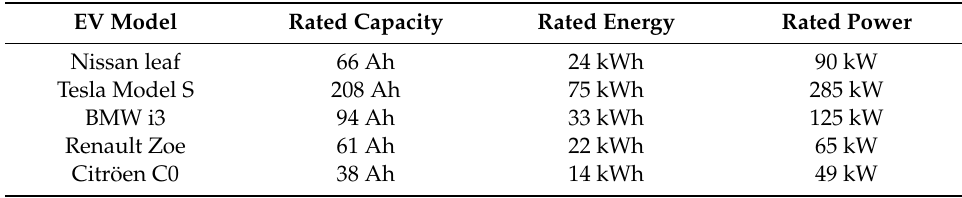
Table 5. Sizing of dedicated I-Life ESS for CSs by using di ff erent battery